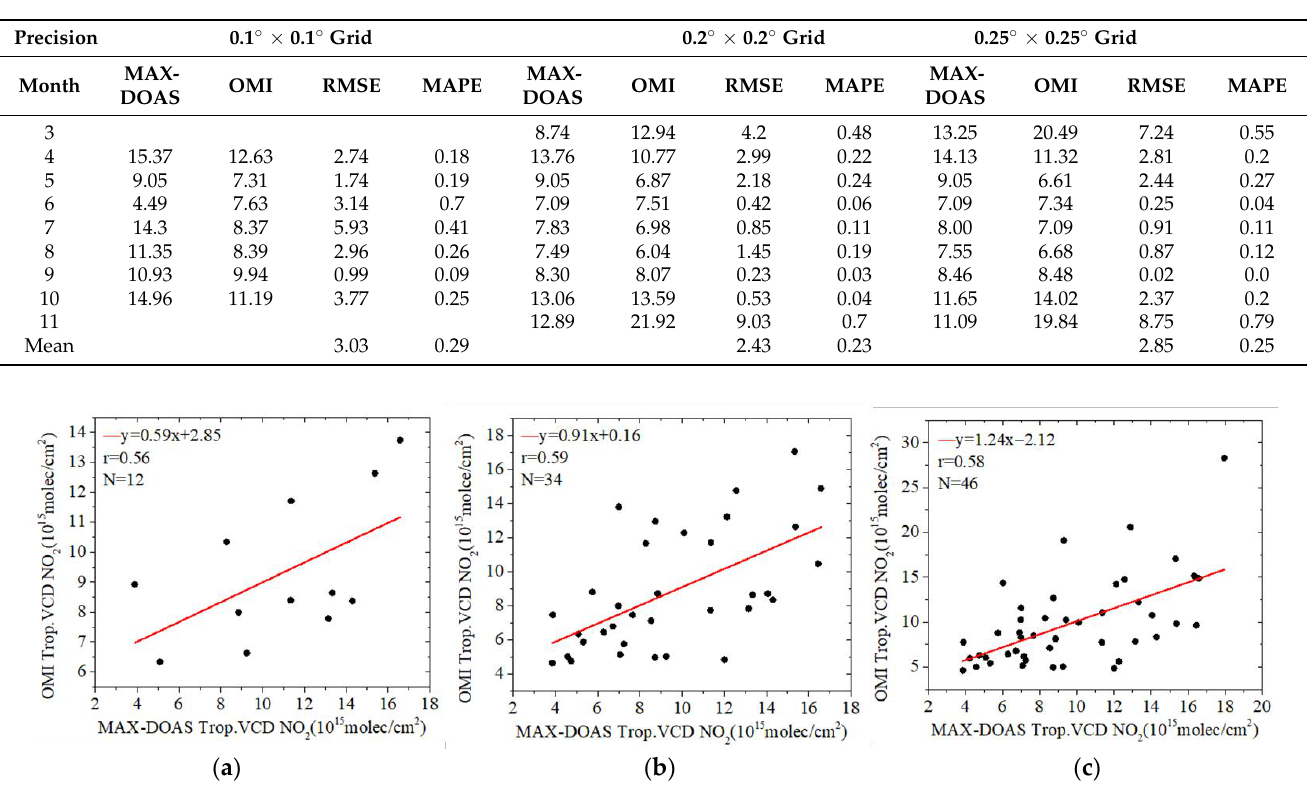
Table 2. Comparison of the monthly averaged NO 2 measured by MAX-DOAS to the OMI (unit: 10 15 molec/cm 2 ).